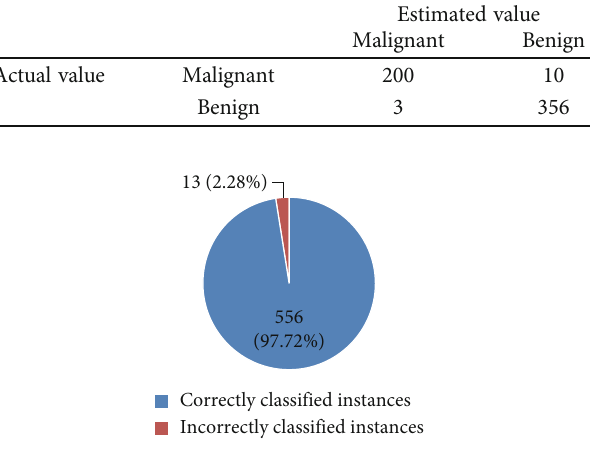
Figure 7: Success percentages of the SVM